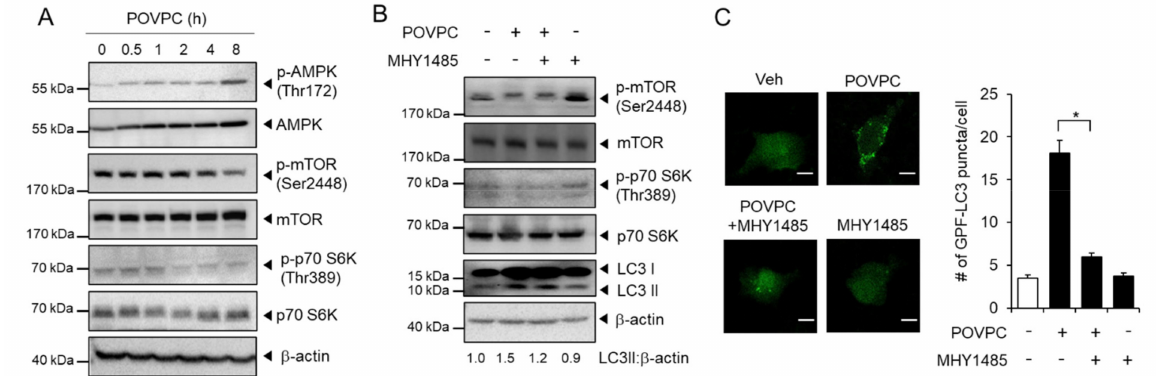
Figure 4. POVPC-induced autophagic flux is mediated through the AMPK-mTOR pathway. ( A ) HepG2 cells were treated with 5 µ g/mL of POVPC for the indicated time periods. The levels of each protein were determined by immunoblotting as indicated with β -actin as the loading control. ( B ) HepG2 cells were treated with MHY1485 (10 µ M) and/or POVPC (5 µ g/mL) as indicated for 8 h. The levels of each protein were determined by immunoblotting as indicated with β -actin as the loading control. + means corresponding treatment and - means vehicle treatment. ( C ) HepG2 cells expressing GFP-LC3 were treated with MHY1485 (10 µ M) and/or POVPC (5 µ g/mL) for 8 h. The representative fluorescence images are presented (left). The scale bar represents 20 µ m. The bar graph shows the number of GFP-LC3 puncta in each cell (right). Values in the line graphs represent the mean ± SEM ( n = 3). *, p <